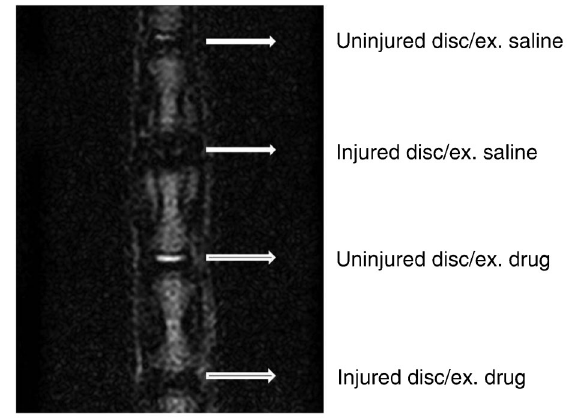
Figure 8. Hypothetical experimental design at adjacent coccy- geal intervertebral levels. This technique allows testing the effect of an innocuous substance or vehicle as control (ex., saline) or the drug of interest both in an injured and uninjured